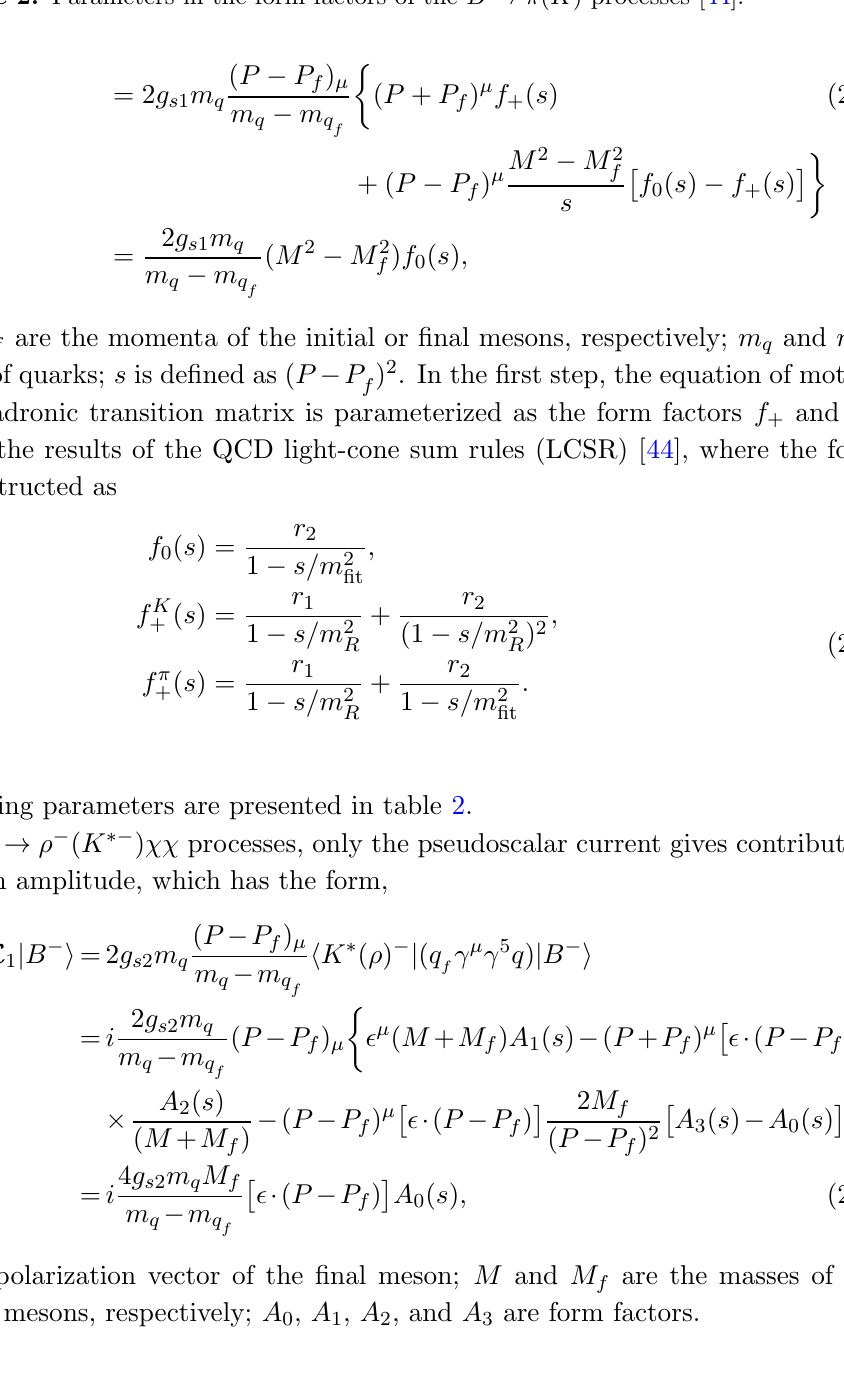
Table 2. Parameters in the form factors of the B